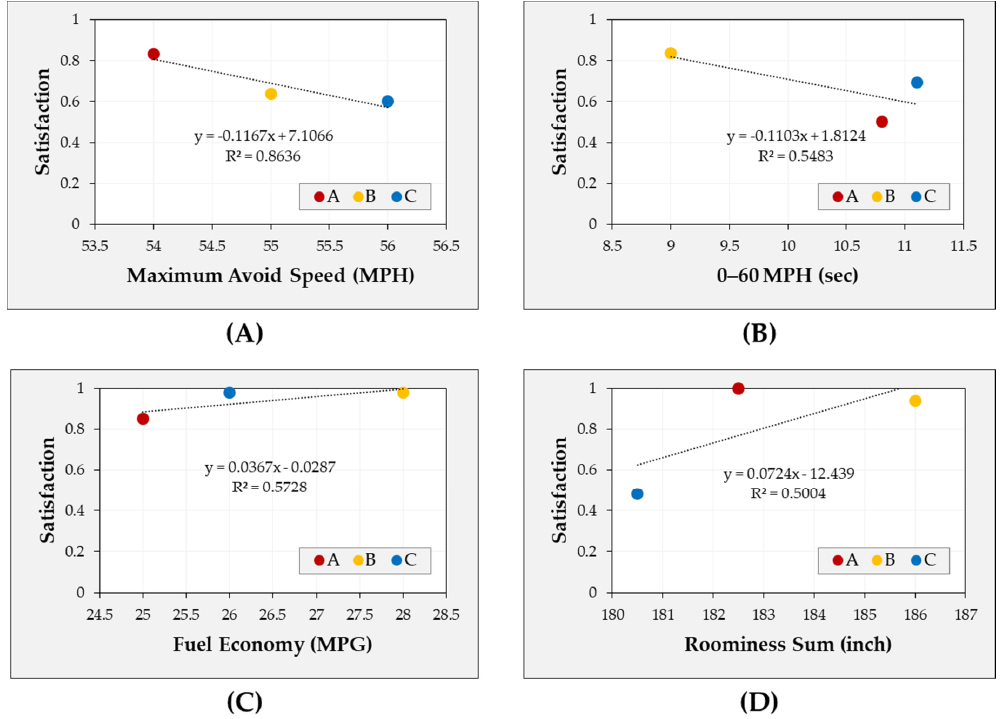
Figure 7. Relationship between satisfaction and several performance categories of subcompact SUV in South Korea: ( A ) handling; ( B ) acceleration; ( C ) fuel economy; ( D ) roominess. in South Korea: ( A ) handling; ( B ) acceleration; ( C ) fuel economy; ( D )